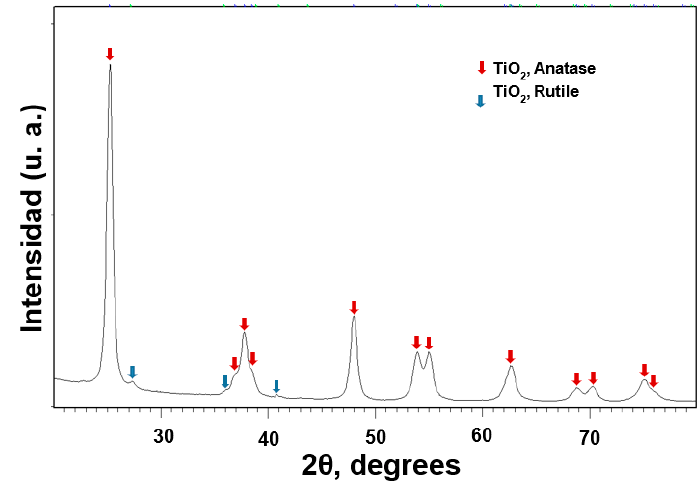
Figure 1. X-Ray Diffraction Pattern from TiO 2 NPs. hydrodynamic diameter size distribution, expressed as number percentage, around 7.5 ± 2.1 nm.